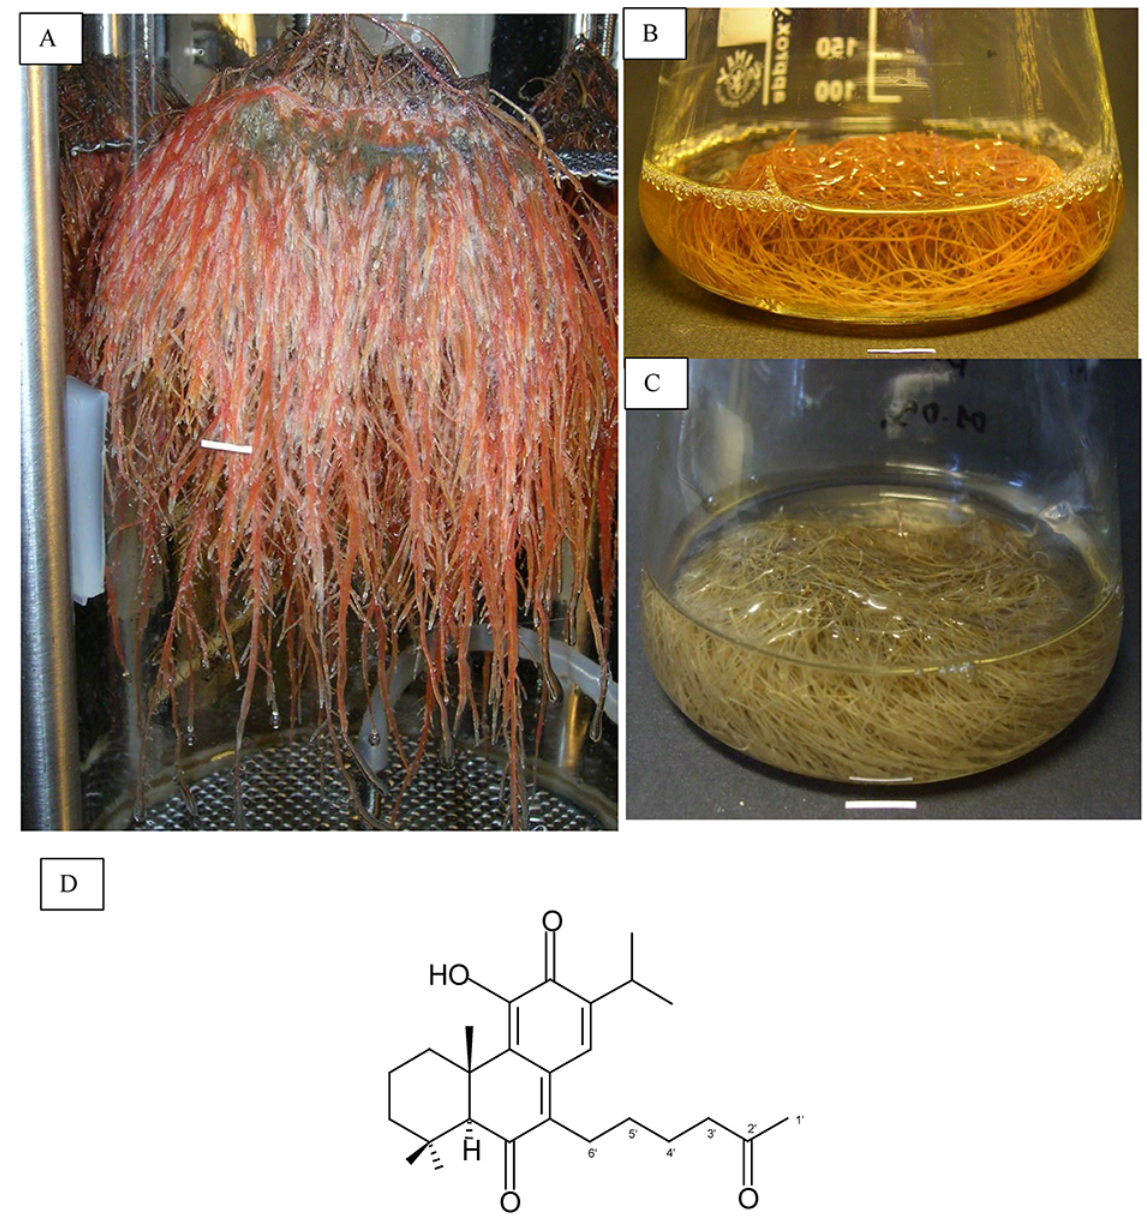
Figure 19 ( A ) irty-day-old Salvia sclarea transformed roots aer elicitation with 125 μM methyl jasmonate (MJ) for 7 days in the nutrient-sprinkle bioreactor. ( B ) Salvia sclarea and ( C ) S. austriaca hairy roots (bar: 1 cm). ( D ) 7-2 ′ -Oxohexyl-taxodione